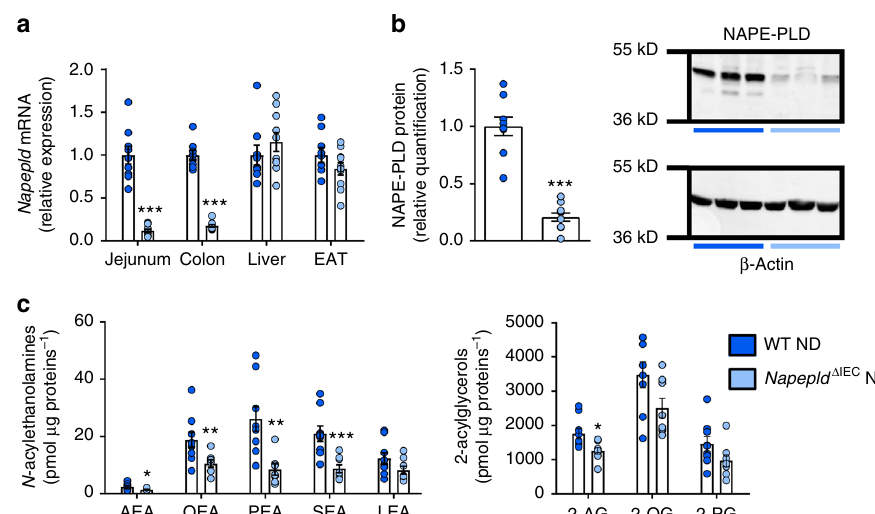
Fig. 1 Validation of IEC Napepld deletion. a Napepld mRNA expression in the jejunum, colon, liver and epididymal adipose tissue (EAT) in ND-fed WT and Napepld Δ IEC mice ( n = 8 – 10). b NAPE-PLD protein levels in the colon. Representative western-blot of NAPE-PLD and β -Actin ( n = 9 – 10). c Levels of N - acylethanolamines and 2-acylglycerols in small intestinal epithelial cells of ND-fed WT and Napepld Δ IEC mice ( n = 7 – 9) were determined by using high- performance liquid chromatography-MS using an LTQ Orbitrap mass spectrometer as described in the methods. Dark blue: WT ND mice, light blue: Napepld Δ IEC ND mice. Data are presented as the mean ± s.e.m. *, ** and *** indicate a signi fi cant difference versus WT ND (Respectively P < 0.05, P < 0.01 and P < 0.001) according to Mann – Whitney test